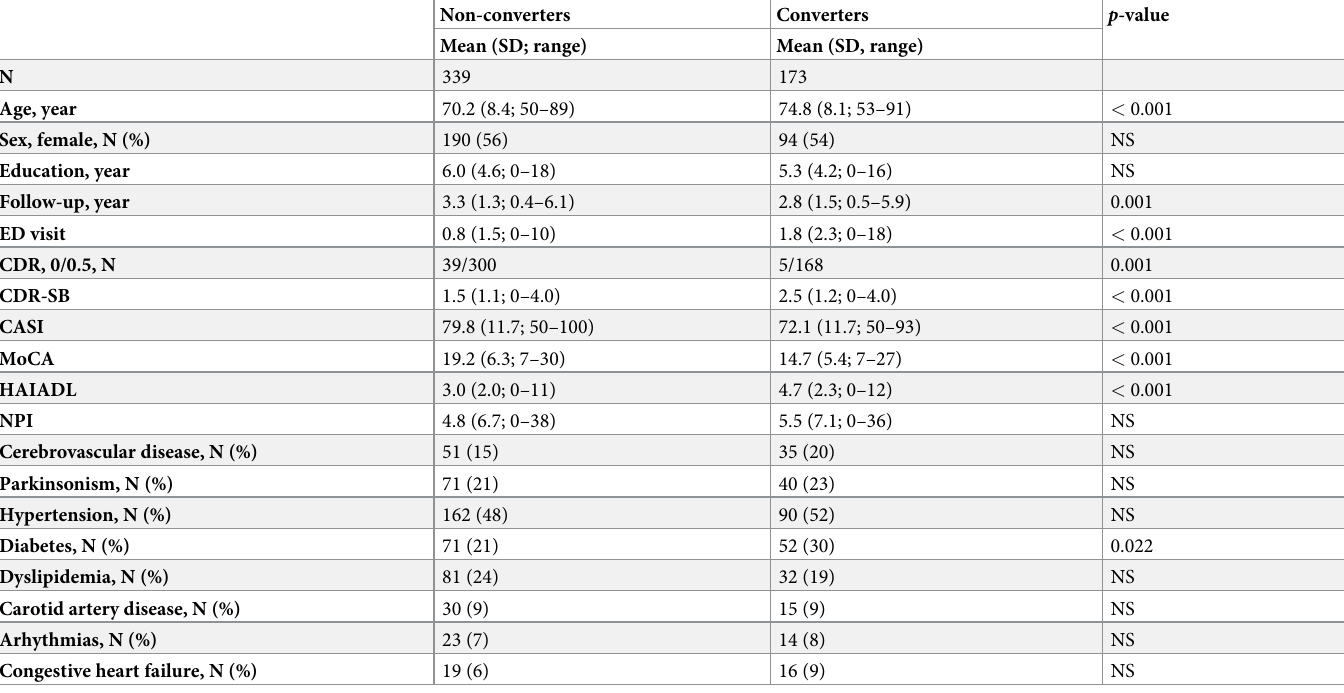
Table 1. Comparison of demographic data between non-converter and converter groups with CDR <